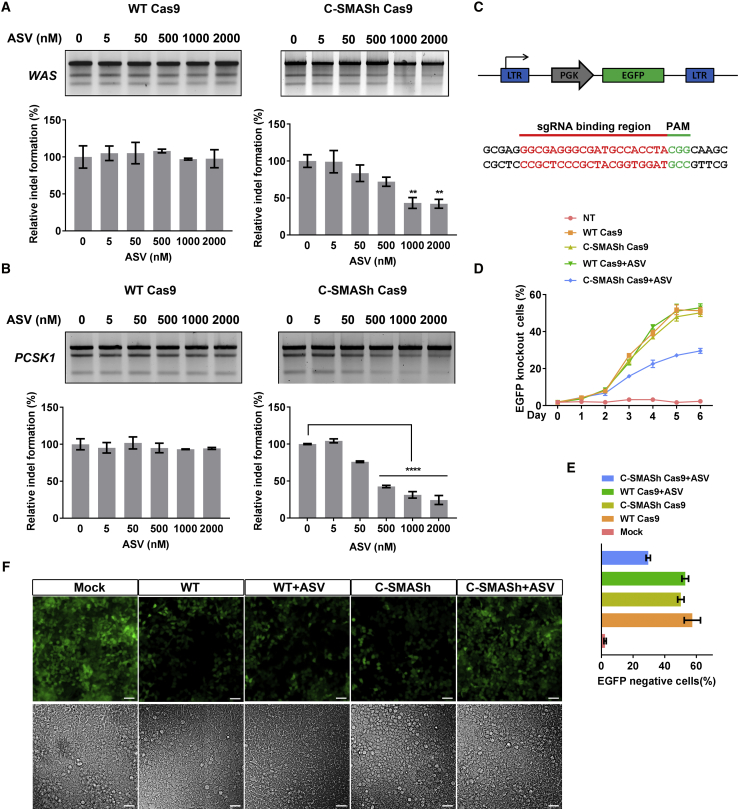
SMASh-Mediated Control of Genome Editing(A and B) Dose-dependent control of genome editing by C-SMASh Cas9. HEK293T cells were co-transfected with the expression plasmid for either WT Cas9 or C-SMASh Cas9 and the expression plasmid for the indicated sgRNA without or with ASV at the indicated concentration for 48 h. Indel-forming efficiencies at the WAS locus in (A) and the PCSK1 locus in (B) were evaluated with the Surveyor assay. The percentage of indels of each sample was quantified as described in Materials and Methods, normalized to that of the control without ASV, and expressed as relative indel formation. Bars represent the mean ± SEM from three independent experiments. **p < 0.01, ****p < 0.0001 by one-way ANOVA and Dunnett’s test for multiple comparison versus non-drug control. (C) Structure of the EGFP lentiviral vector and the sgRNA target sequence in the EGFP gene. (D) EGFP knockout activity of WT Cas9 and C-SMASh Cas9 in the presence of 2000 nM ASV. Knockout efficiency was analyzed using flow cytometry from day 1 to day 6 after transfection of HEK293T-GFP cells with plasmids expressing Cas9 and the sgRNA targeting the EGFP gene shown in (C). Error bars represent SEM from three independent experiments. (E) Quantification of the fraction of EGFP knockout cells on day 6 after transfection based on the data shown in (D). Bars represent the mean ± SEM from three independent experiments. (F) Fluorescence (top) and bright-field (bottom) images of HEK293T-GFP cells 6 days after transfection with the expressing plasmids for Cas9 as indicated and the EGFP sgRNA without or with 2000 nM ASV. Scale bars, 50 μm.